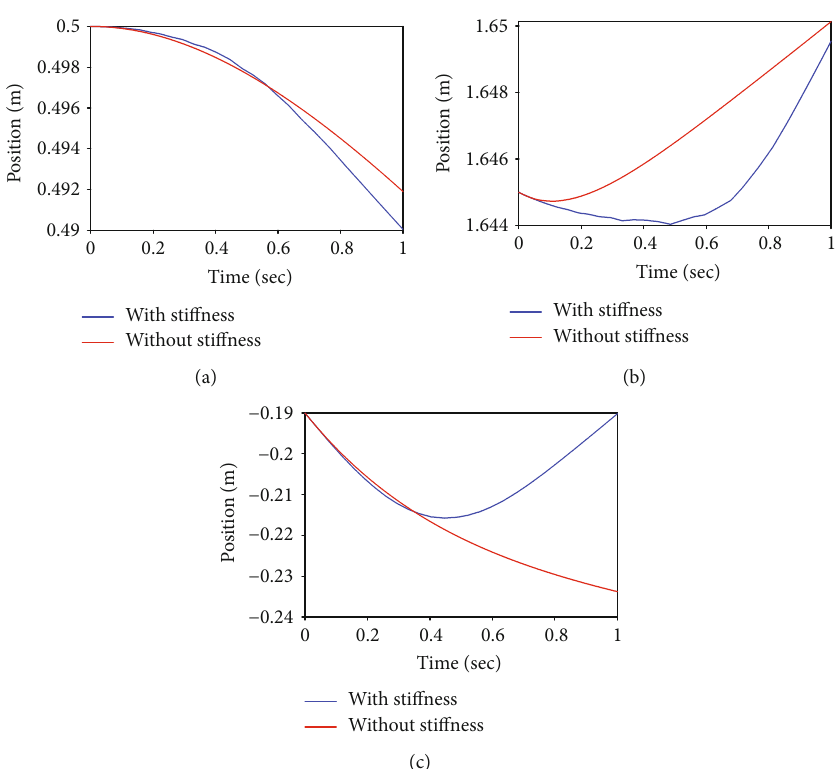
Figure 15: Position of the point O